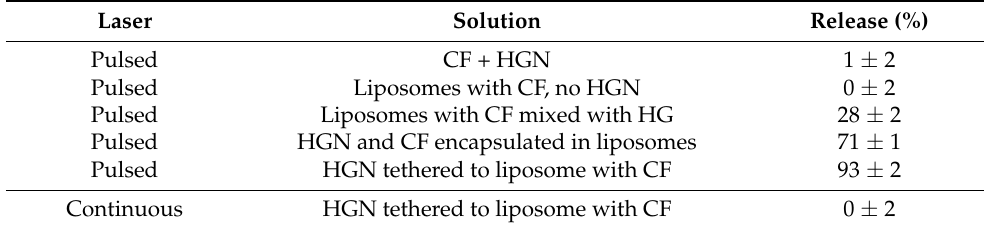
Table 1. Percentage (%) release from